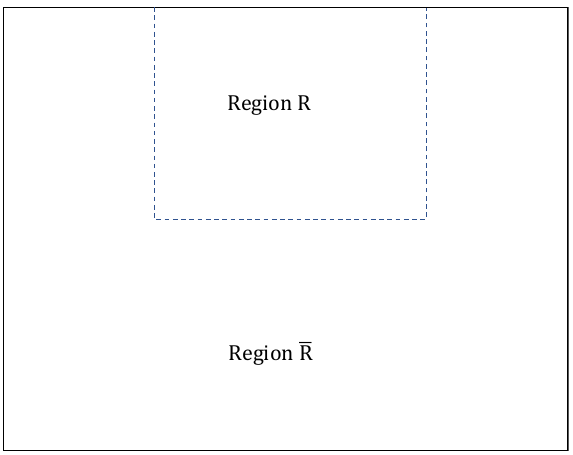
Figure 4 . Region R touching the PB of a